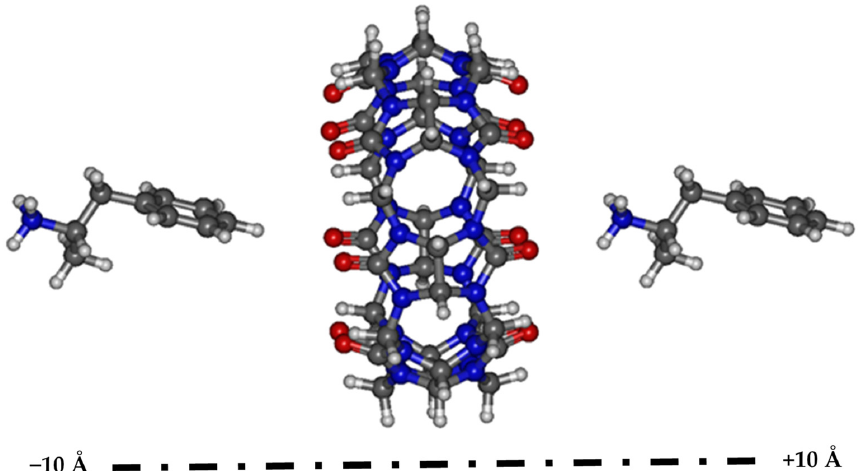
Figure 1. Docking orientations of S-AMP@CB[7] from − 10 Å to +10 Å. Color code: carbon, grey; nitrogen, blue; oxygen, red; hydrogen, white.